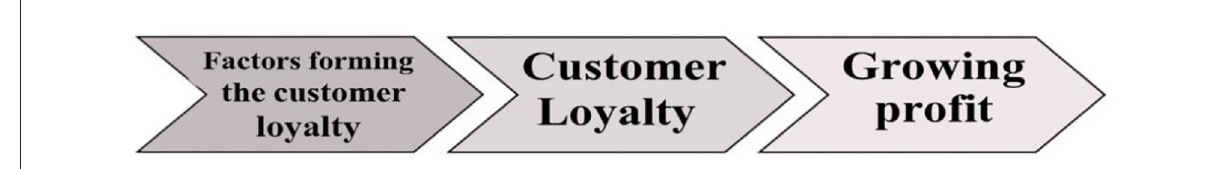
FIGURE4 Model of customer loyalty.